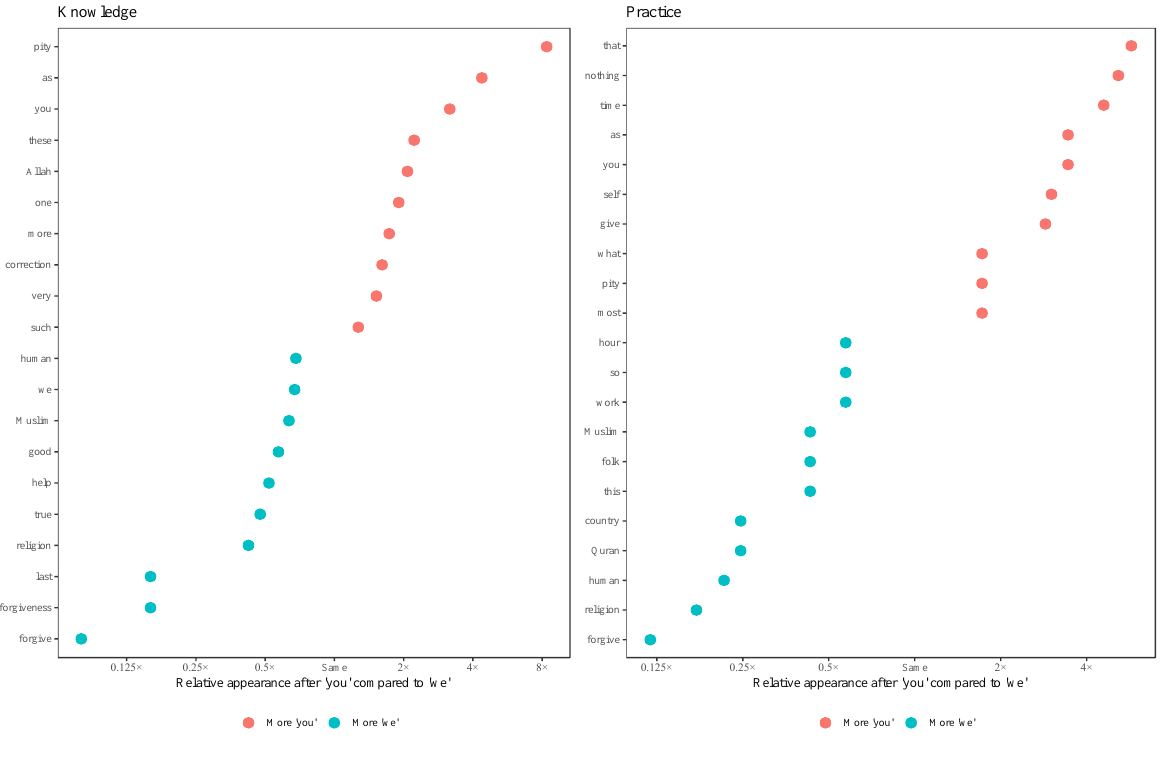
Figure 4. The first ten words with the most considerable significant co-occurrence differences.